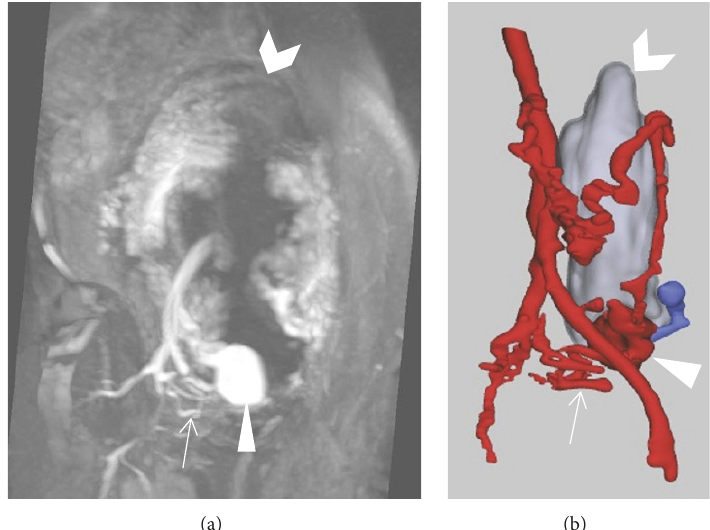
Figure 5: (a) Sagittal oblique reconstruction of T1 MRA and 3D surface rendered image (Vital Images postprocessing software) (b) of uterine artery feeder (arrows) to the pseudoaneurysm (arrowheads). Uterine cavity